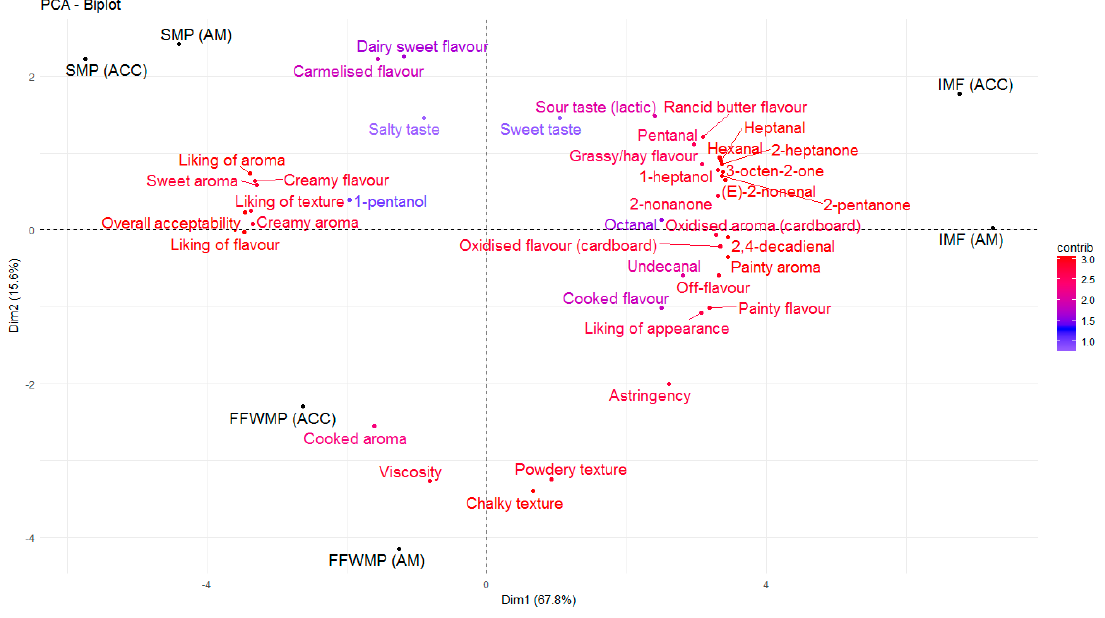
Figure 2. Principle component analysis (PCA) biplot of fat-filled whole milk powder (FFWMP), skim milk powder (SMP), and infant milk formula (IMF) samples at T8 demonstrating the trends observed throughout the study for the ranked descriptive analysis (RDA) and volatile analyses. AM: ambient, 21 °C; ACC: accelerated, 37 °C.